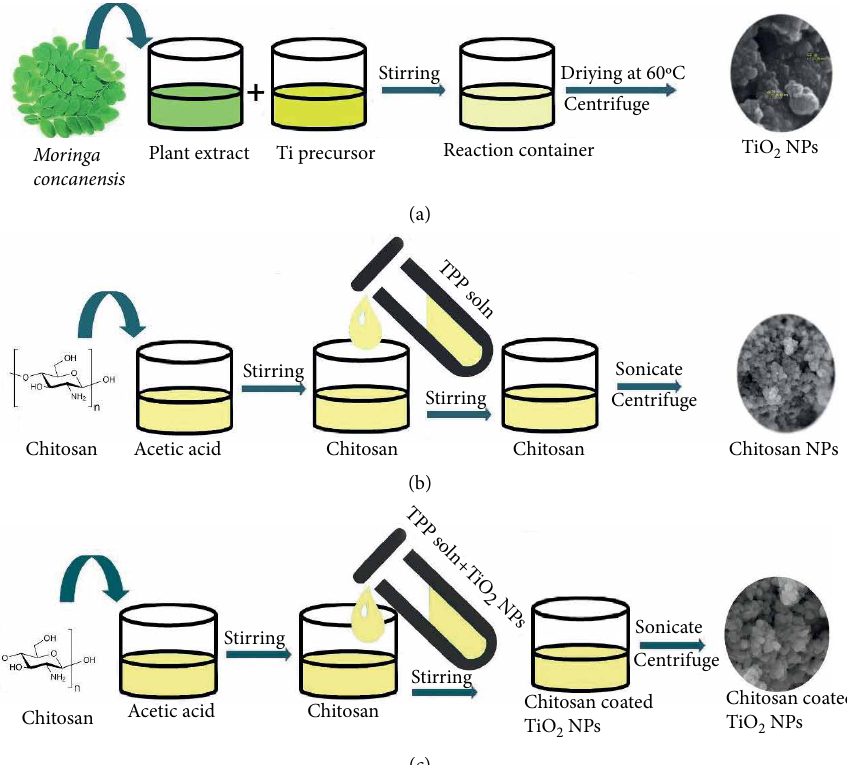
Figure 1: Crucial steps involved for synthesis of Nano antimicrobial agents. (a) synthesis of TiO TiO 2